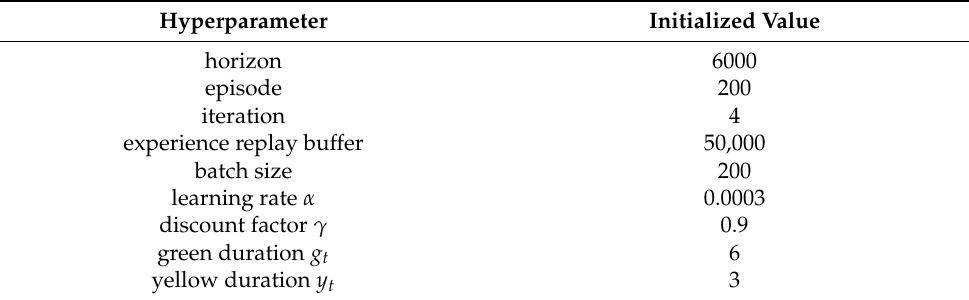
Table 4. Hyperparameter setting of